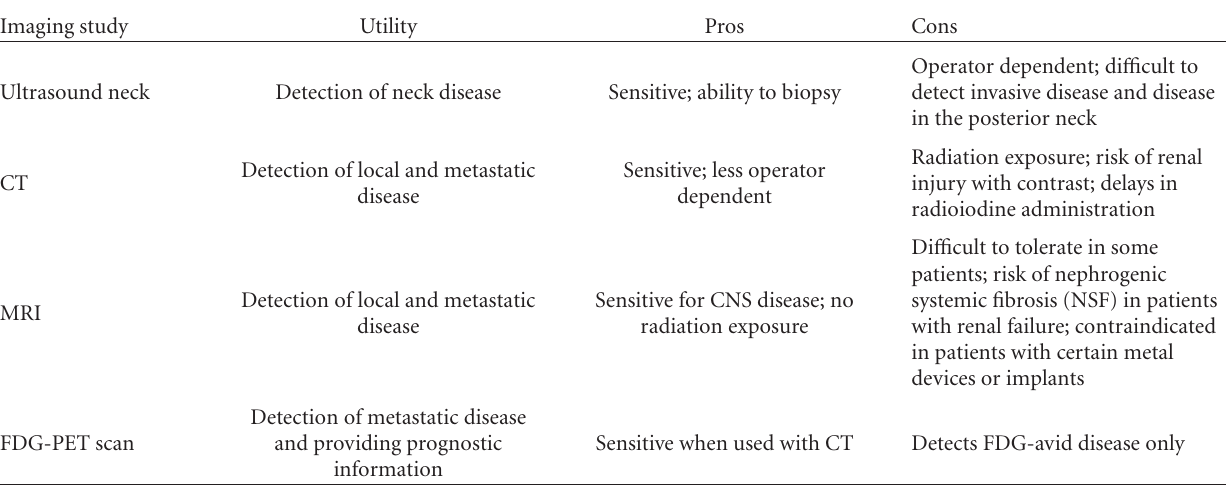
Table 1: Imaging modalities for RAI-refractory recurrent